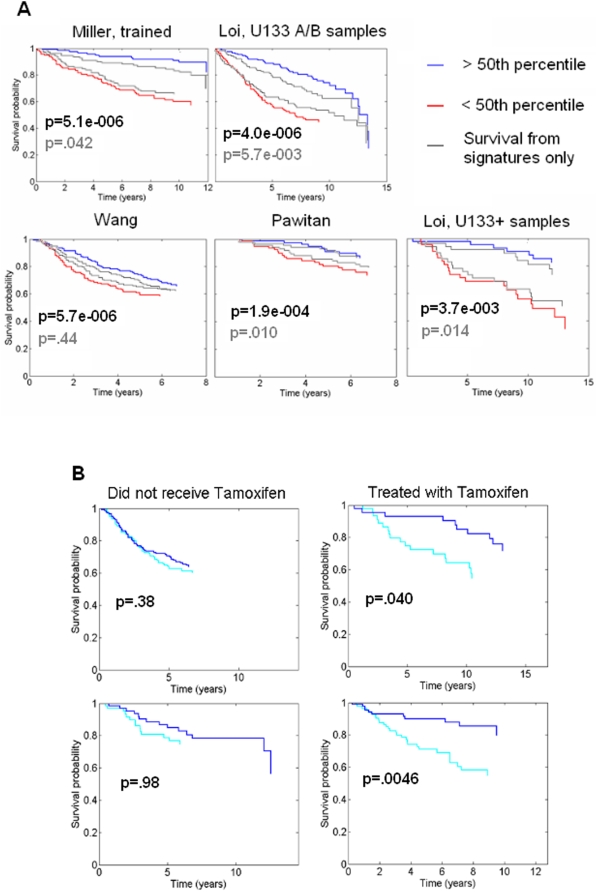
Predicting survival and drug response.(a) Predicted survival times from an average of Weibull survival models where used to split the 251 samples from [21] according to above/below median predictions, and the resulting empirical survival curves (Kaplan Meier curves) are shown. The red/blue stratification of patients is from the analysis using subsets of the 67 factors (red - high risk 50%, blue low risk 50%); the grey curves are from the same analysis using all of the original five signatures (thus there is no compensation for over-fitting here). The p-values in each of the plots correspond to stratification by factor analysis (top, black) and stratification using the signatures (bottom, grey). Data from [21] was used to identify the survival models, therefore this plot represents fitted values. The four additional plots represent prediction in the four different breast tumor samples based on the analysis of only the training data. The predictive relevance, and importance, of the factors is evident and consistent across studies, and consistently improves on that achieved by use of signatures alone. (b) The first Lactic Acidosis factor predicts survival in patients who were treated with Tamoxifen (left half), but shows no predictive value in patients who did not receive the drug (right half). In all of these figures, p-values represent significance in a cox proportional hazards model.